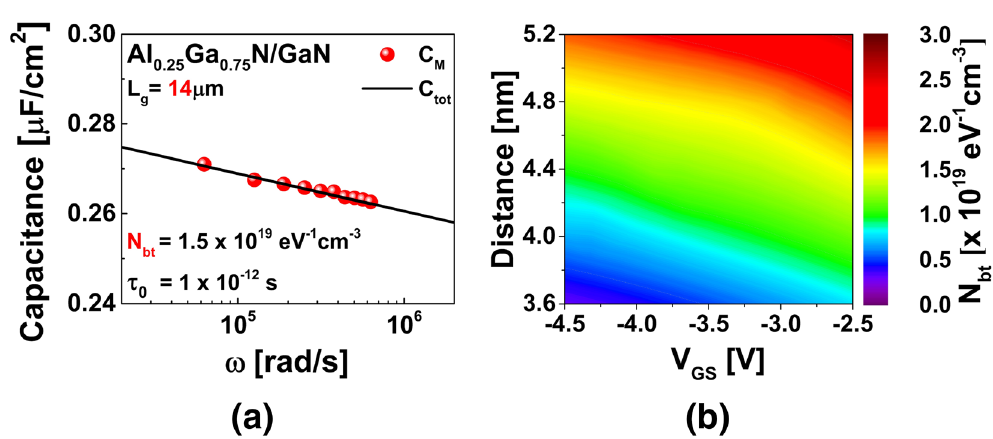
Figure 4. ( a ) Fitting curves generated using distributed circuit model at V GS = − 3.5 V. ( b ) Contour mapping of border trap distribution in